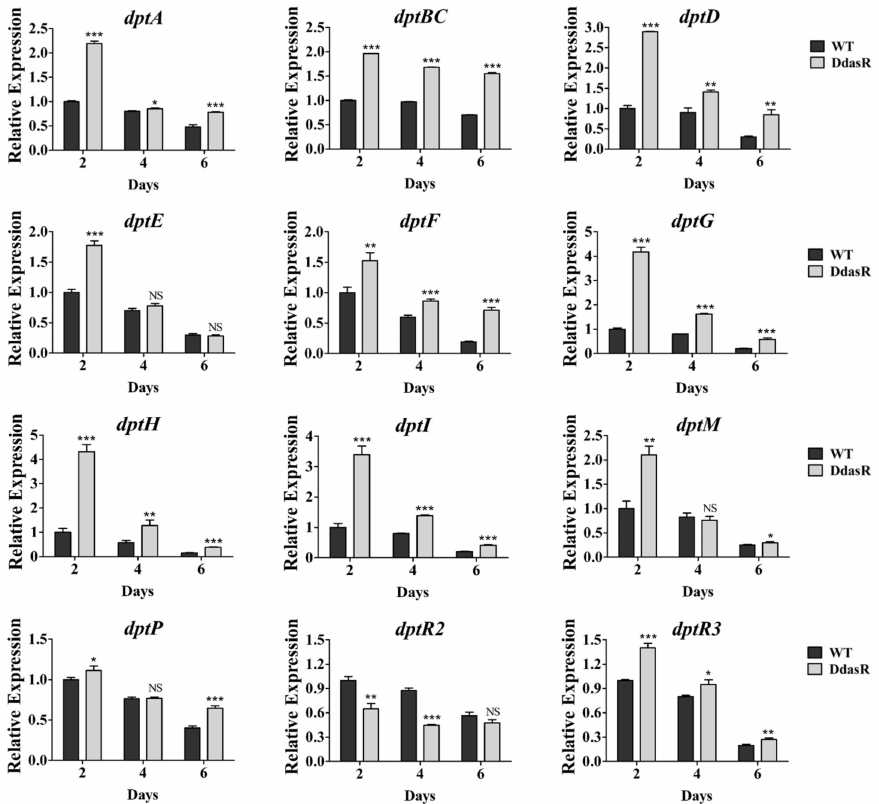
Figure 2. RT-qPCR analysis of dpt genes in WT and DdasR grown in fermentation medium for 2, 4, or 6 days. WT transcription level for each gene on day 2 was defined as 1. NS, not